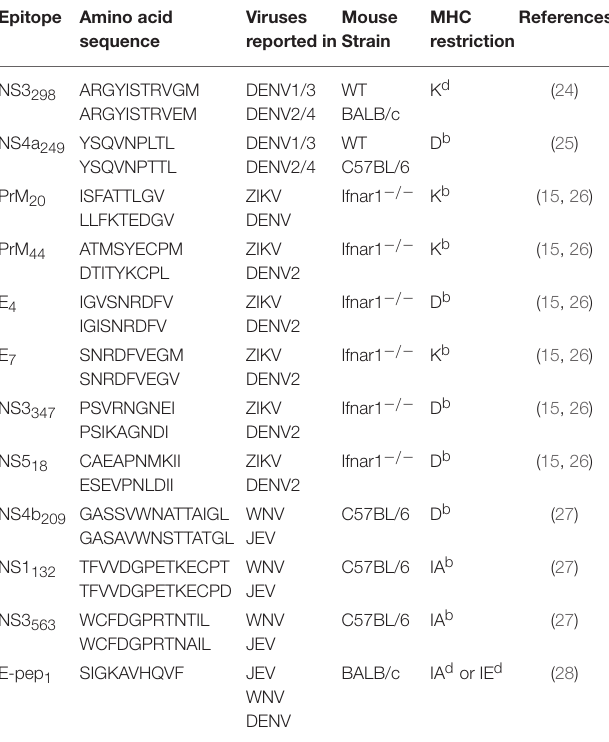
TABLE 2 | Flavivirus cross-reactive T cell epitopes with murine MHC restriction identified using various murine models, named in the same manner as the papers they were identified